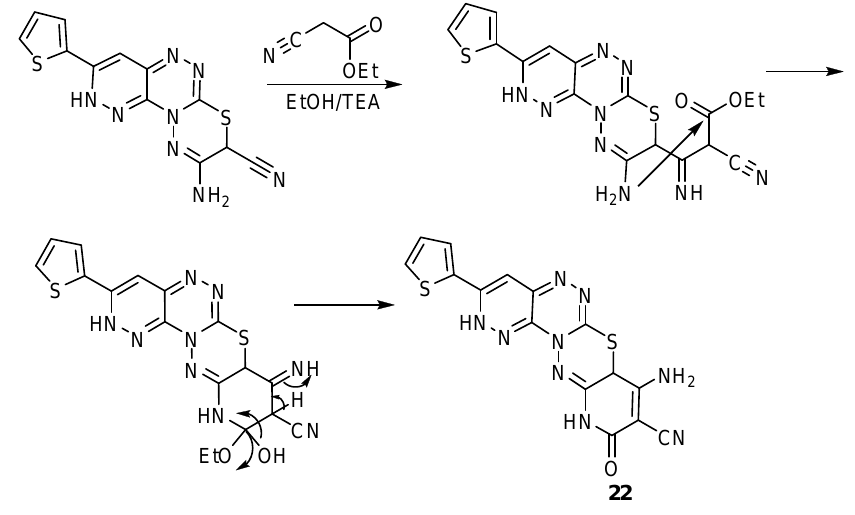
Scheme 8. Mechanism of formation of compound 22 .